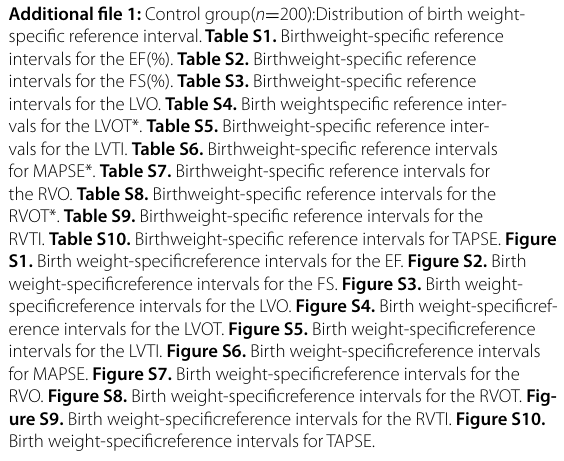
vals for the LVTI. Table S6. Birthweight‑specific reference intervals for MAPSE*. Table S7. Birthweight‑specific reference intervals for the RVO. Table S8. Birthweight‑specific reference intervals for the RVOT*. Table S9. Birthweight‑specific reference intervals for the RVTI. Table S10. Birthweight‑specific reference intervals for TAPSE. Figure S1. Birth weight‑specificreference intervals for the EF. Figure S2. Birth